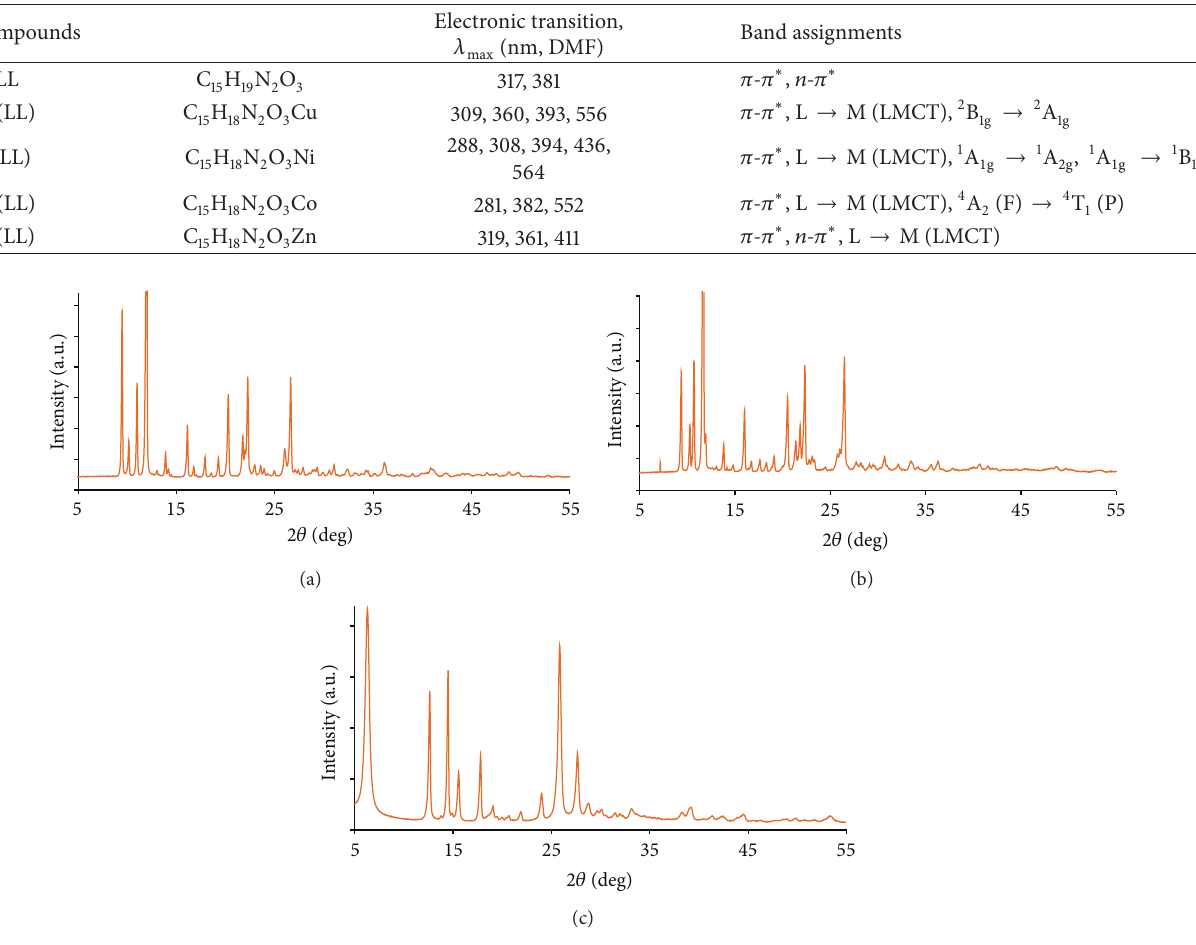
LL] and its metal complexes. 2